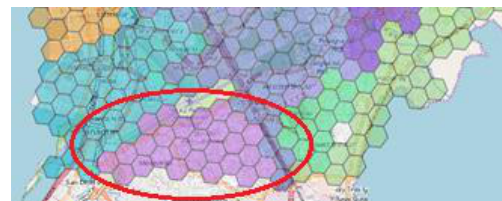
Figure 10. An example of prevalent cluster (encircled in red) that appears in all six hourgroups.